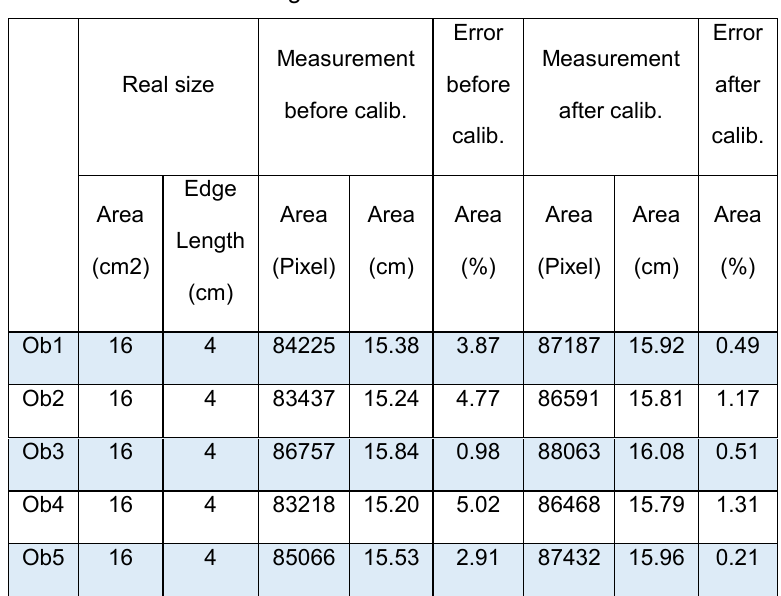
Table 3. The calibration result of